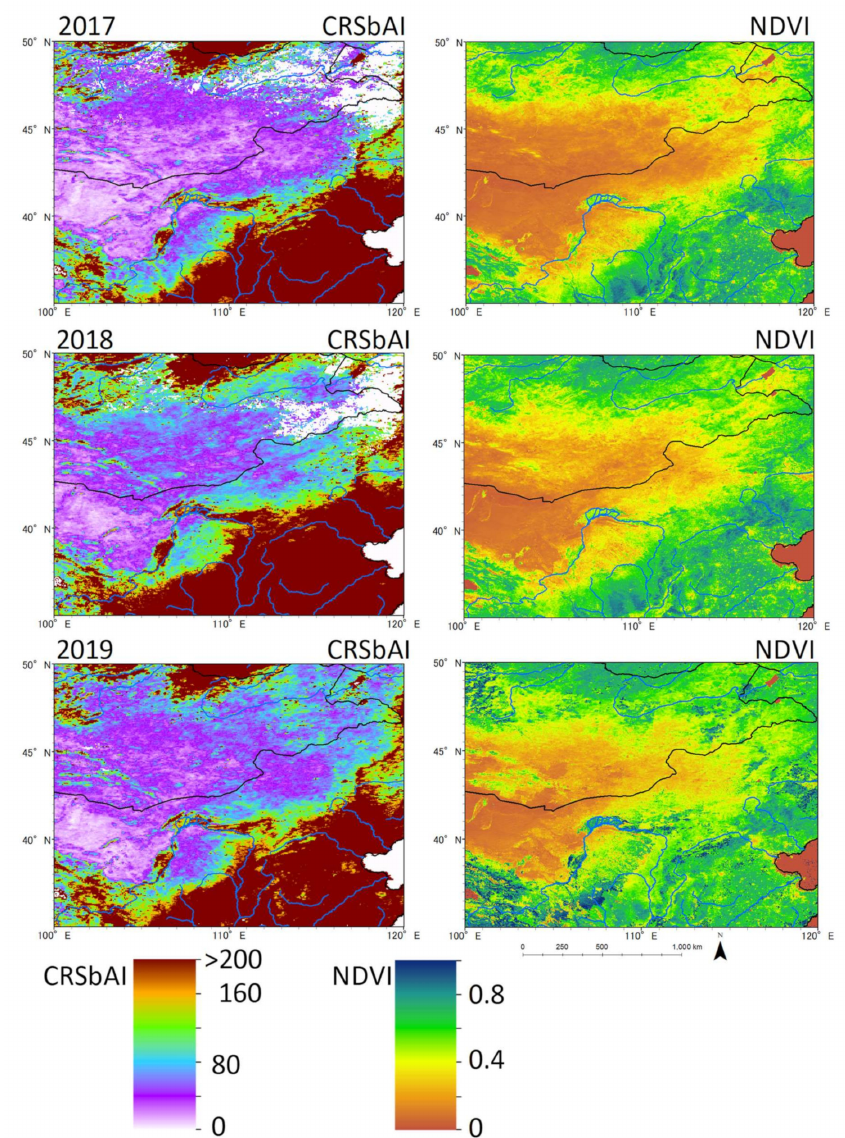
Figure 9. Spatial distributions of the CRSbAI (monthly) and NDVI in August in north-east Asia from 2017 to 2019. White areas indicate where cloud cover prevented